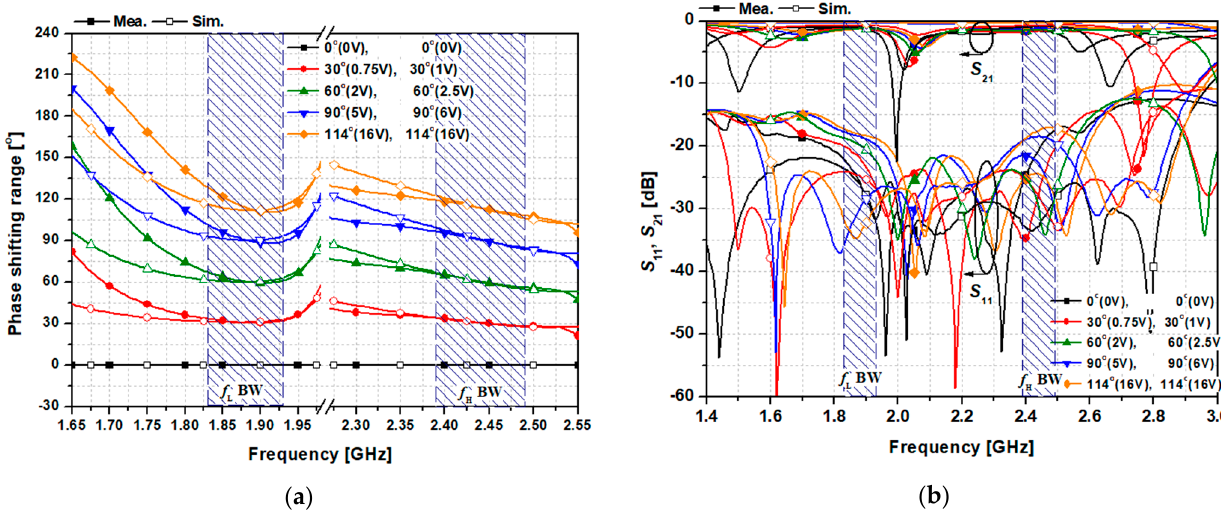
Table 6. Performance of the proposed design against state-of-art alternatives.